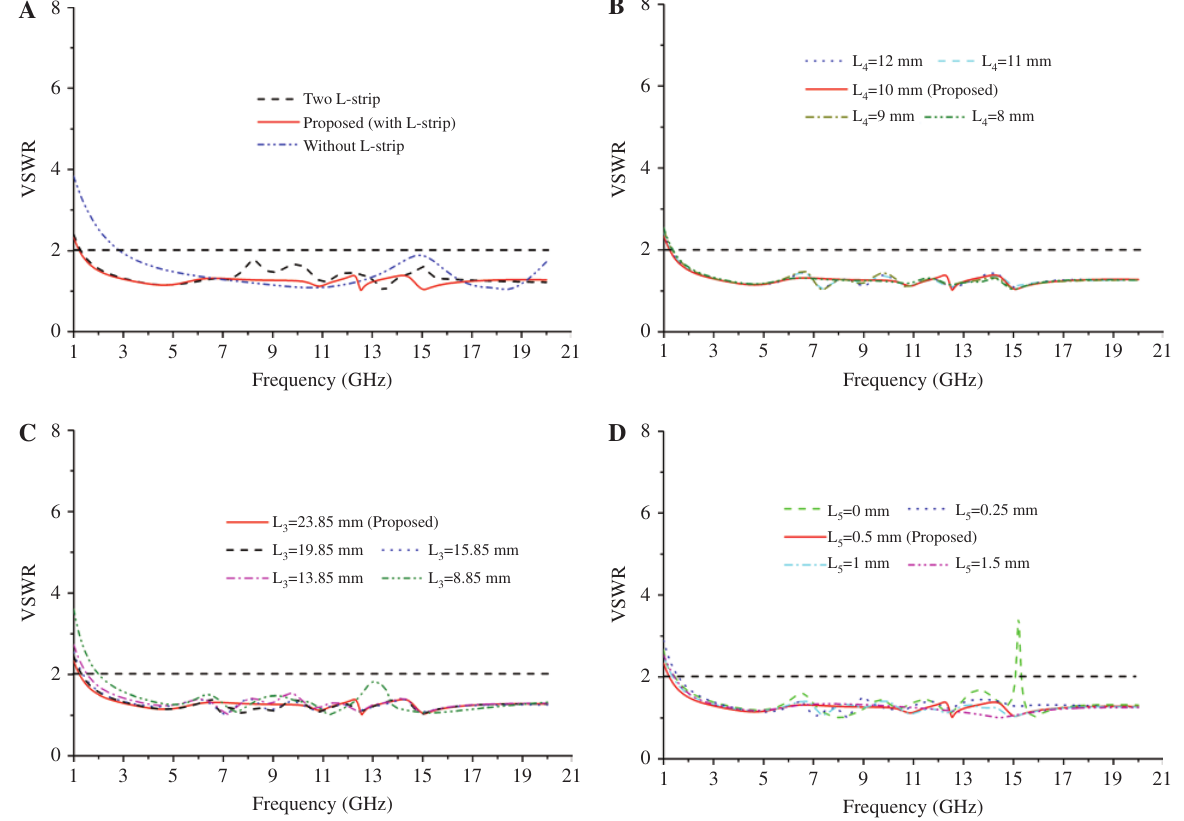
Figure 5: Effects of varying ground plane-related parameters: (A) number of L-type slit, (B) L-type slit horizontal length, (C) L-type slit verti- cal length, and (D) L-type slit